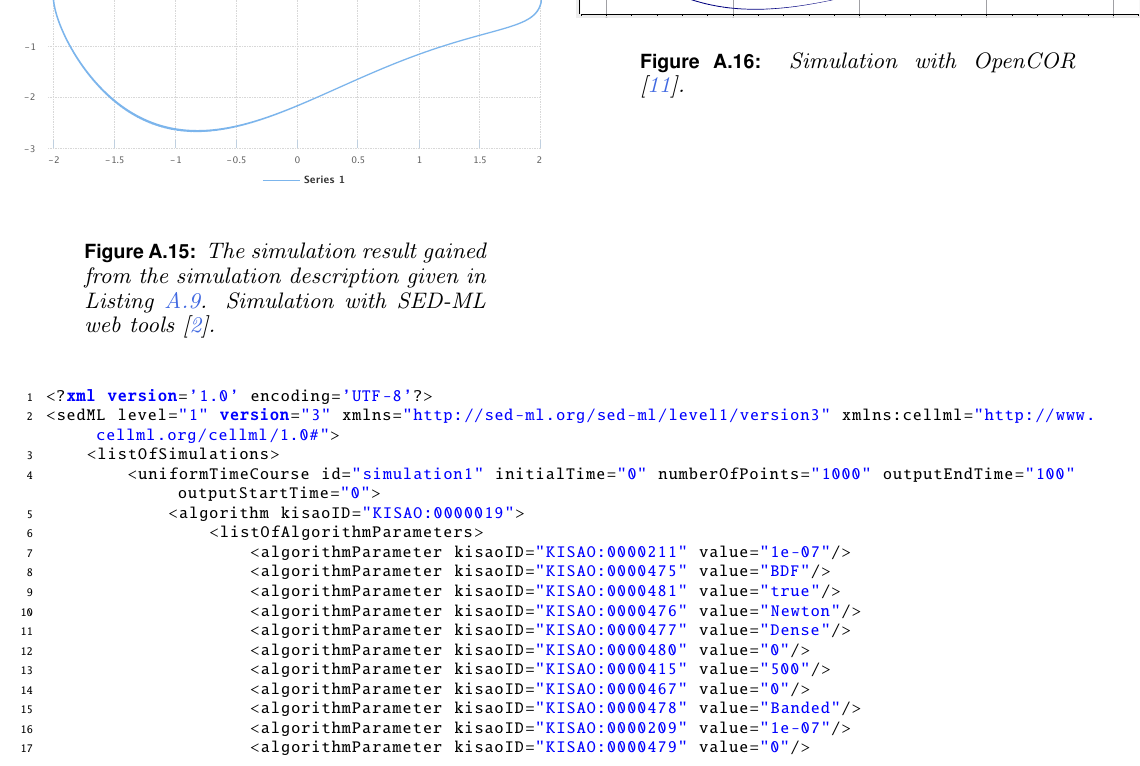
Figure A.16: Simulation with OpenCOR